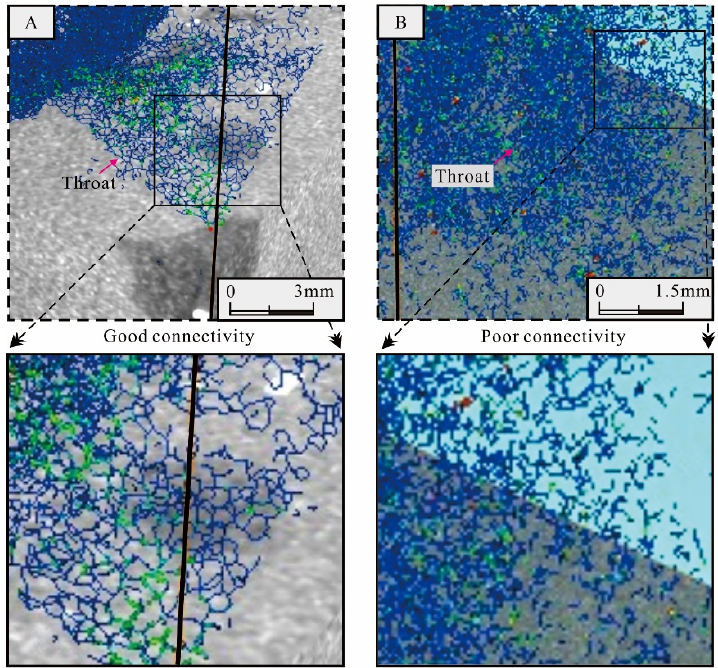
Figure 14. The radius distribution and count of the pores and throats of the Sample B' and Sample E'. ( A ) Sample B' pore radius; ( B ) Sample E' pore radius; ( C ) Sample B' throat radius; ( D ) Sample E' throat radius.